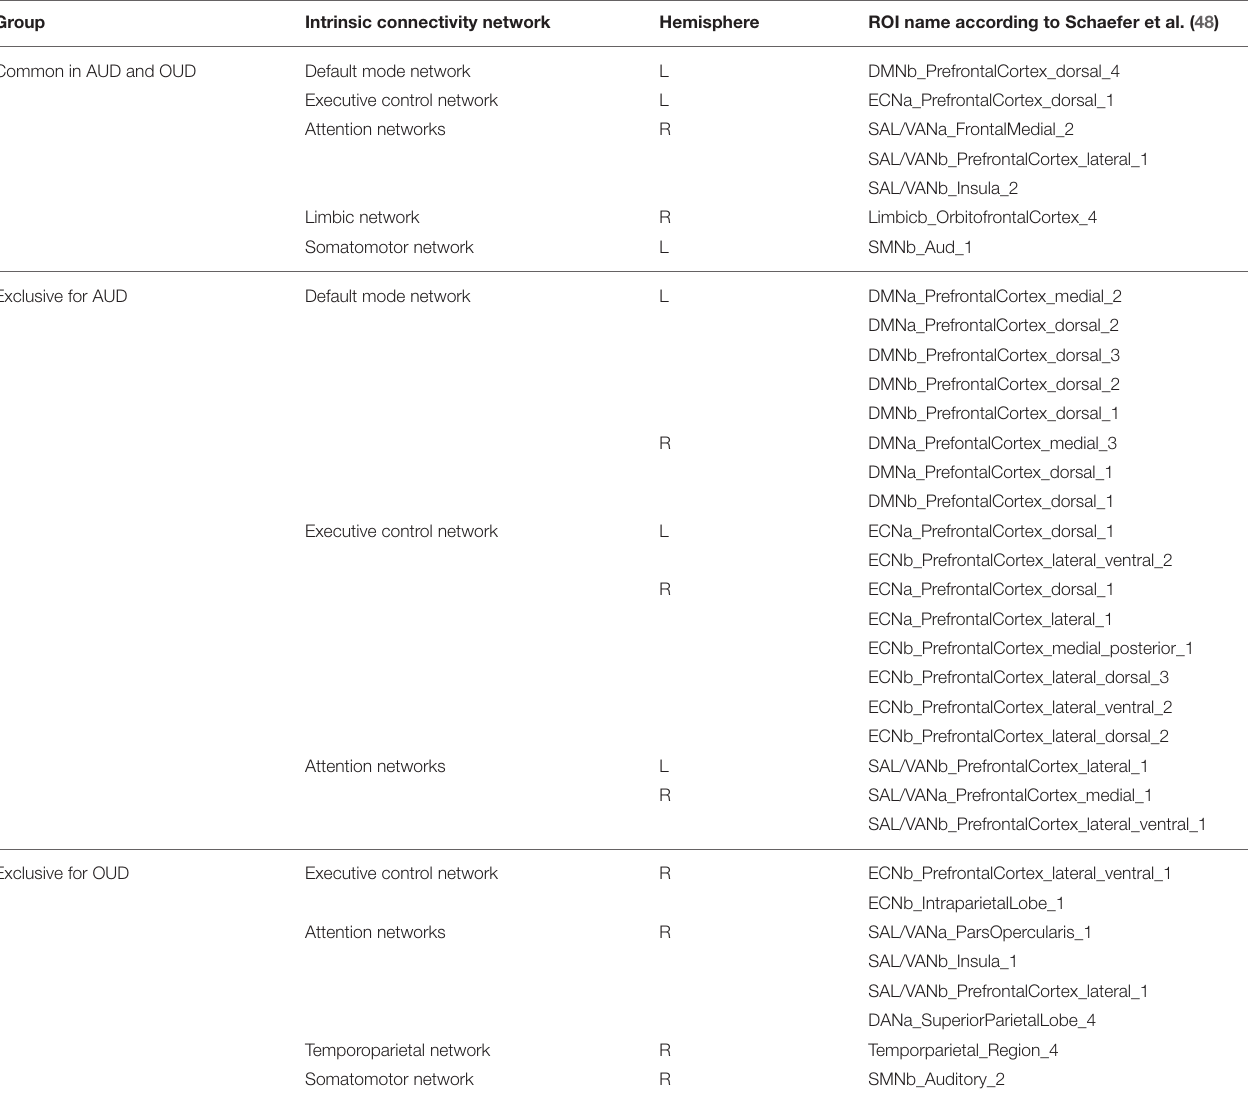
The table lists the results of the data-driven ROI analysis at p < 0.01 FDR corr.; AUD, alcohol use disorder individuals; OUD, opioid use disorder individuals. The naming of the regions of interest (ROI) follows the convention of the Schaefer parcellation (48), which assigns the 200 ROI to 17 different networks with corresponding subnetworks differentiated by lower